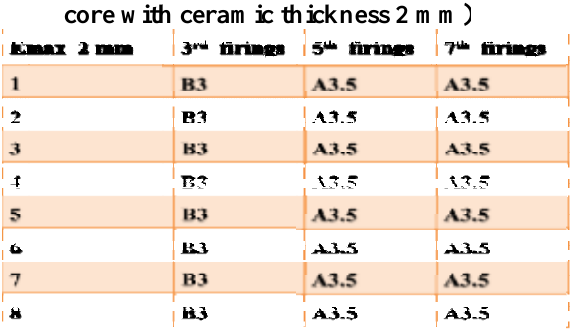
Table 6: Shade results of group B2